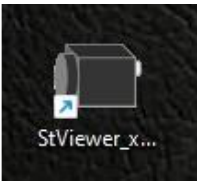
Figure 29. StViewer software executable.